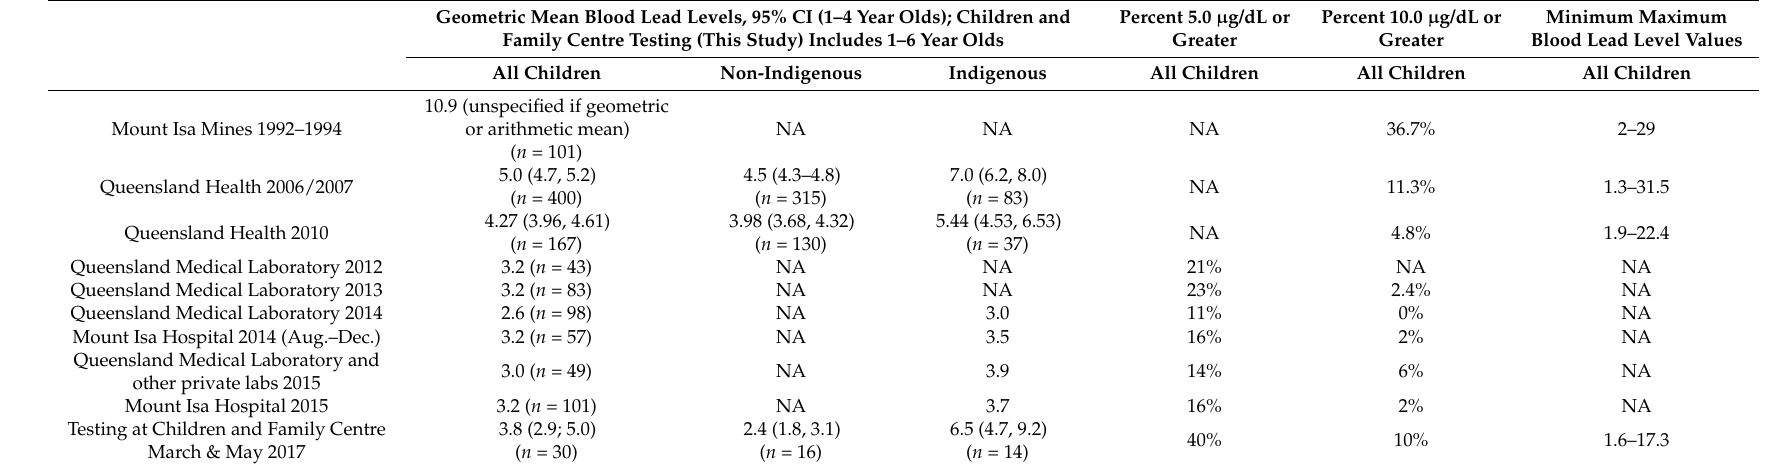
Table 1. Reported blood lead levels for children in Mount Isa,